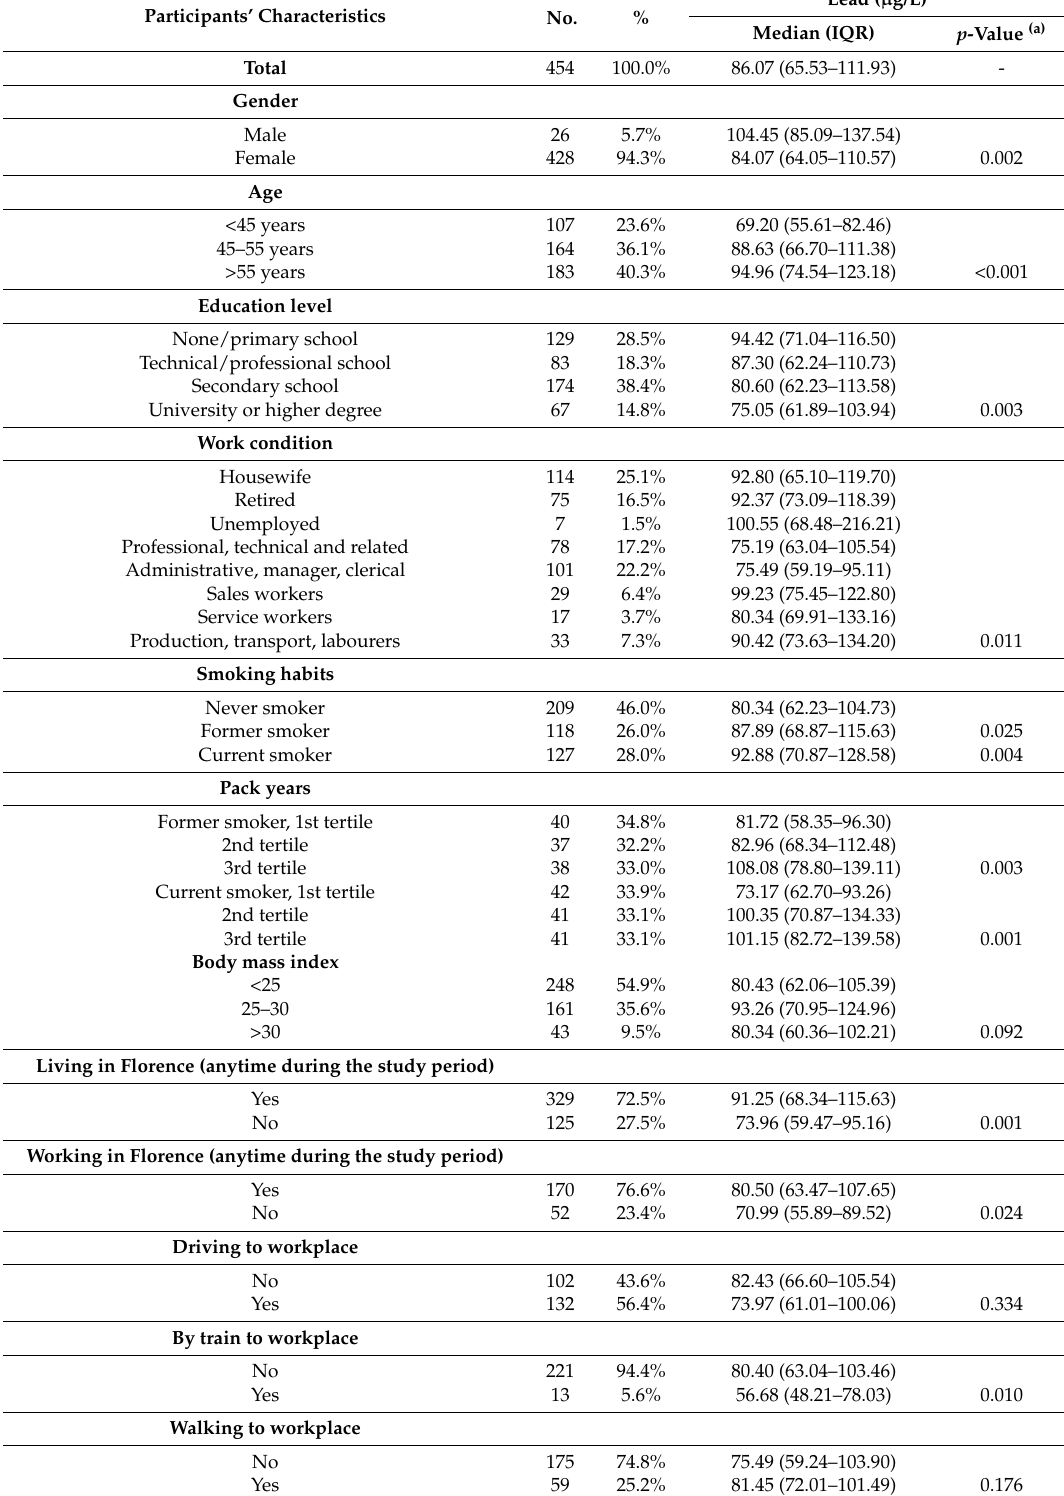
Table 1. Erythrocyte lead levels ( µ g/L) according to selected participants’